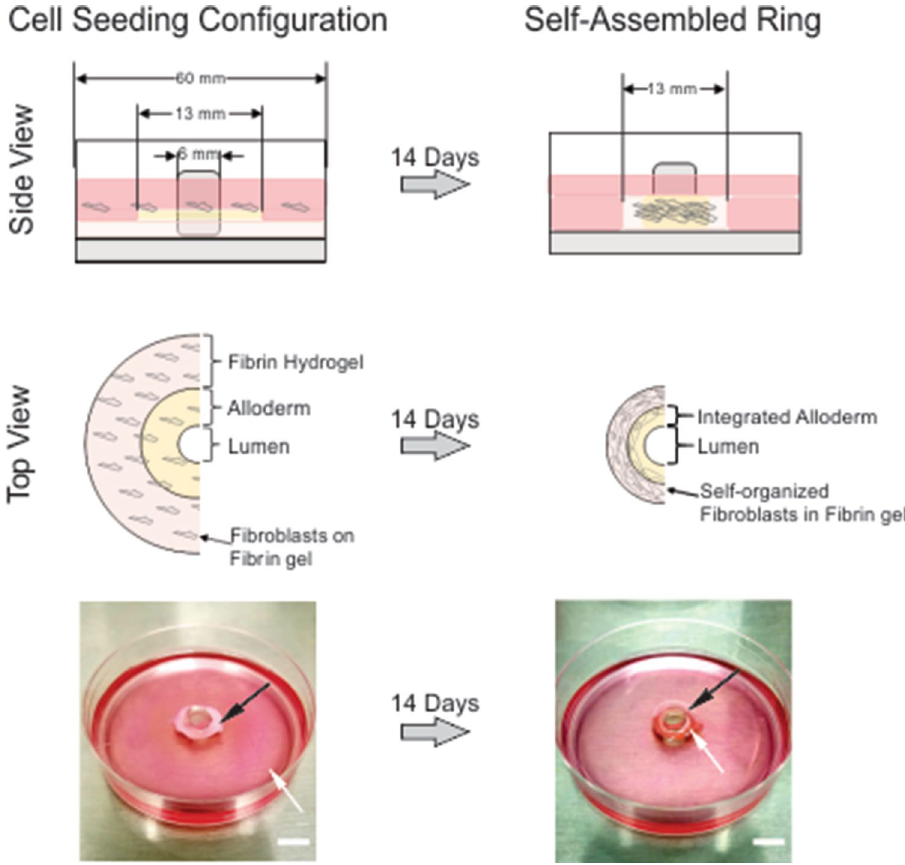
Figure 1. Diagram of self-assembled rings with incorporated Alloderm. Alloderm was integrated into the engineered vascular rings by placing the ECM material into the plate prior to cell seeding. Fibroblasts were seeded on top of the Alloderm and hydrogel, and the cells were able to infiltrate both the Alloderm ECM and hydrogel. Plate images show the progression of the engineered vascular ring formation 1 day and 14 days following seeding, showing the cell monolayer with hydrogel (edge indicated by white arrows) and the location of the Alloderm (black arrow) in the final ring tissue. Scale bar = 1